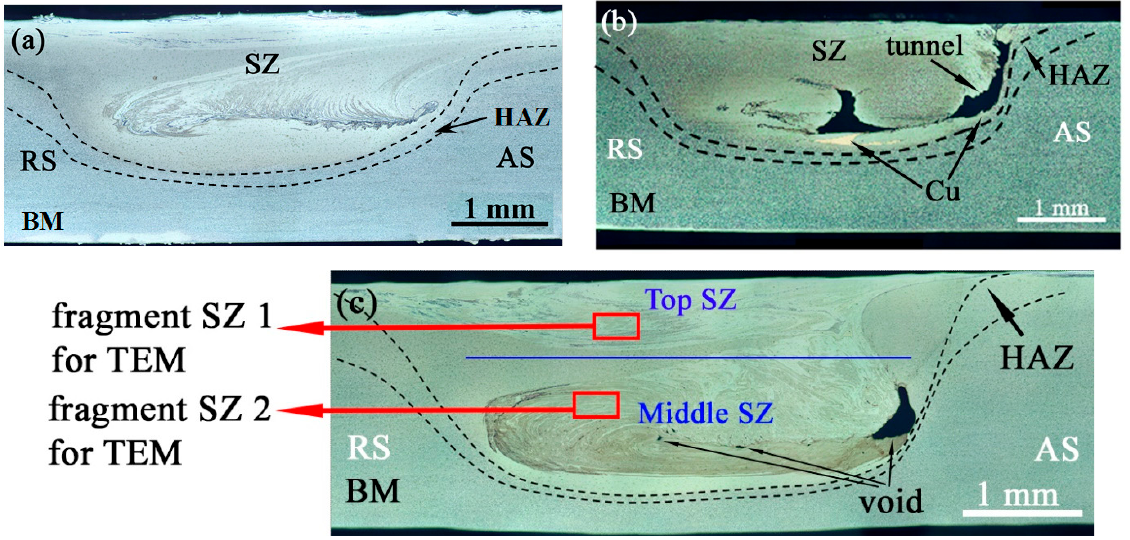
Figure 3. The stir zone macrostructures after 4-pass FSP on Ti6Al4V ( a ), single-pass FSP on Ti6Al4V/Cu ( b ), and 6-pass FSP on Ti6Al4V/Cu ( c ). SZ—stir zone; RS—retreating side; BM—base metal; HAZ—heat-affected zone; AS—advancing side.